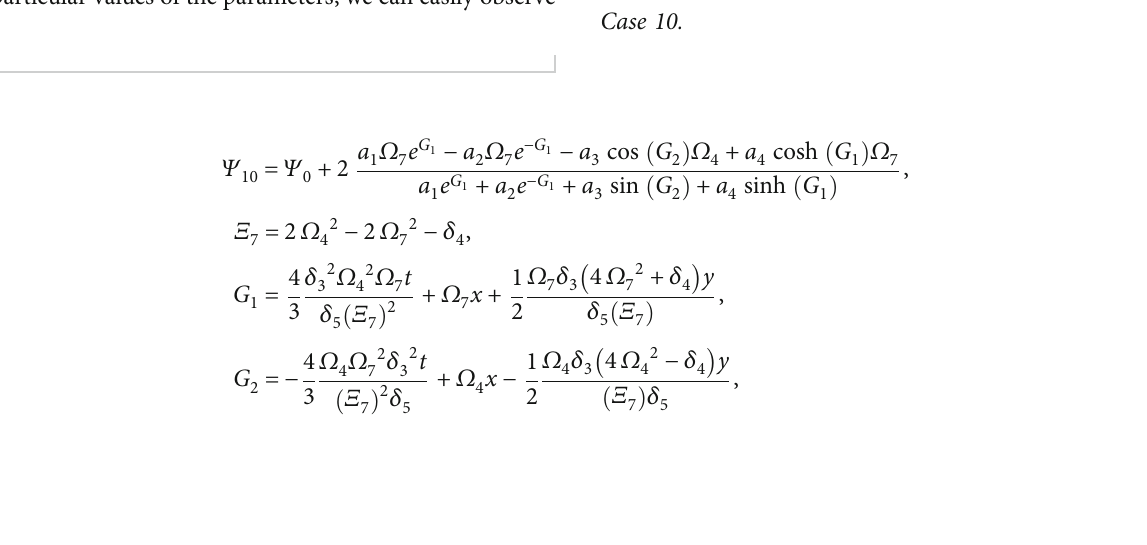
Figure 6: Plot evolution of periodic waves (26) utilizing values a = 2, δ = 1 : 3, δ = 2, Ψ = 1, t = 10 and (a) 3D plot, (b) density plot, and (c) contour δ 3 4 5 0